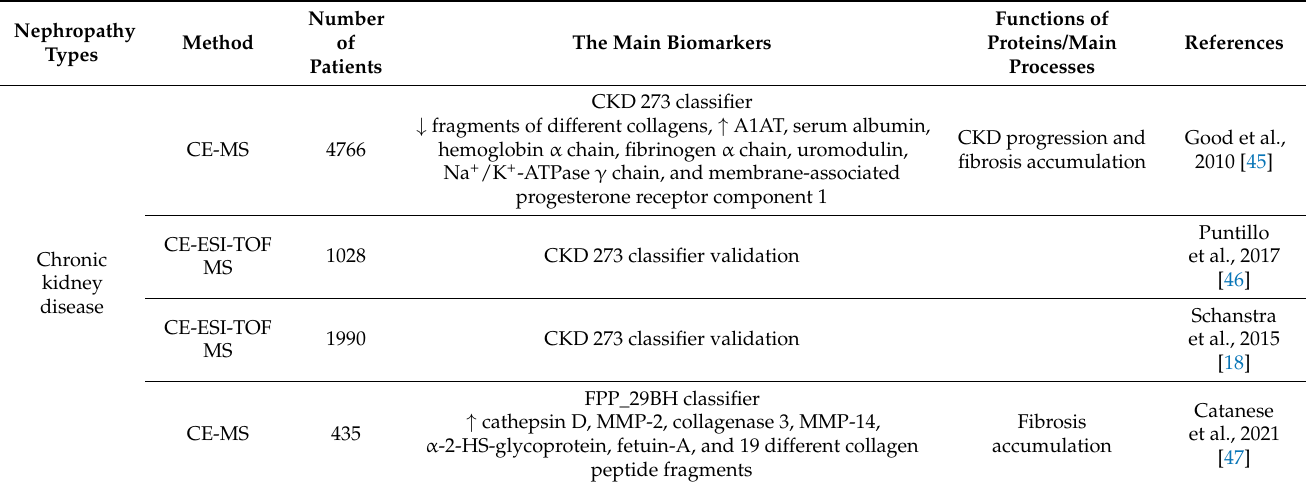
Figure 1. Study flow chart. Table 1. Urine proteome studies in different types of